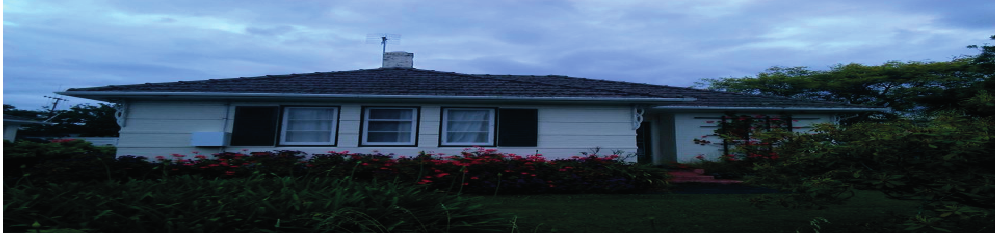
Figure 1. Image of real house where smart home monitoring and a control system are